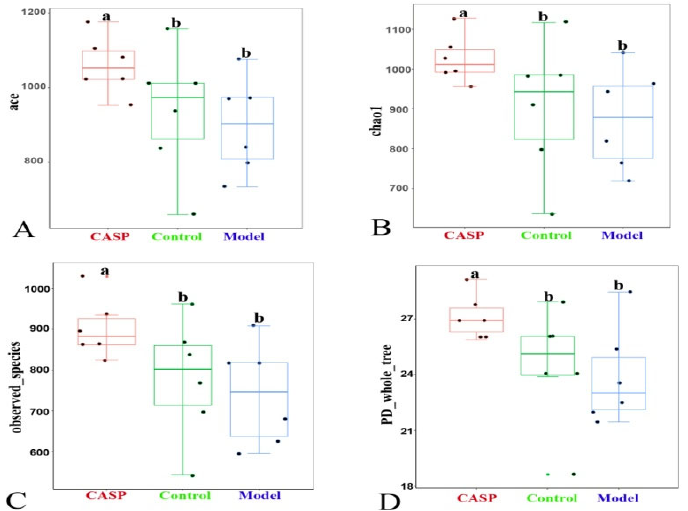
Figure 7. The α -diversity analysis of cecum content floras in each group. Note: ( A ) Box chart of ace index difference between groups; ( B ) Box chart of Chao 1 index difference between groups; ( C ) Box chart of observed species index difference between groups; ( D ) Box chart of PD whole tree index difference between groups. The same letter, and the different letter indicate that the inter ‐ group difference is non ‐ significant or significant, respectively.